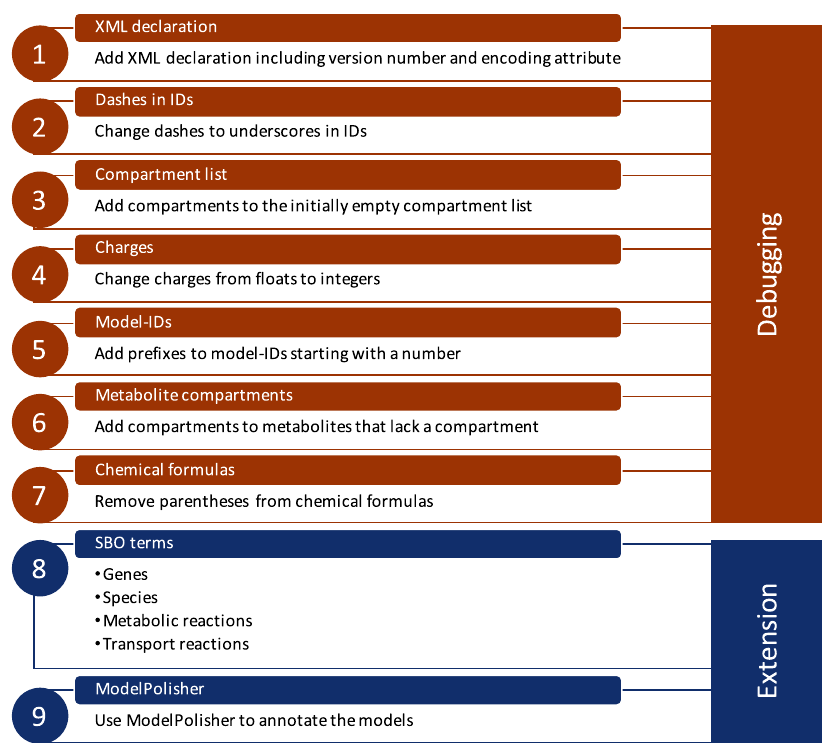
Fig. 3 Debugging and extension steps in GEMs by Bosi et al. Not all the 64 SBML fi les downloaded from the supplement of Bosi et al. did directly pass the syntactic validation. In seven steps, the errors reported in the validity check were solved to receive valid SBML fi les. The valid fi les were then further extended with appropriate SBO terms for genes, species, and reactions. In a fi nal step, annotations were added to the model using ModelPolisher 69